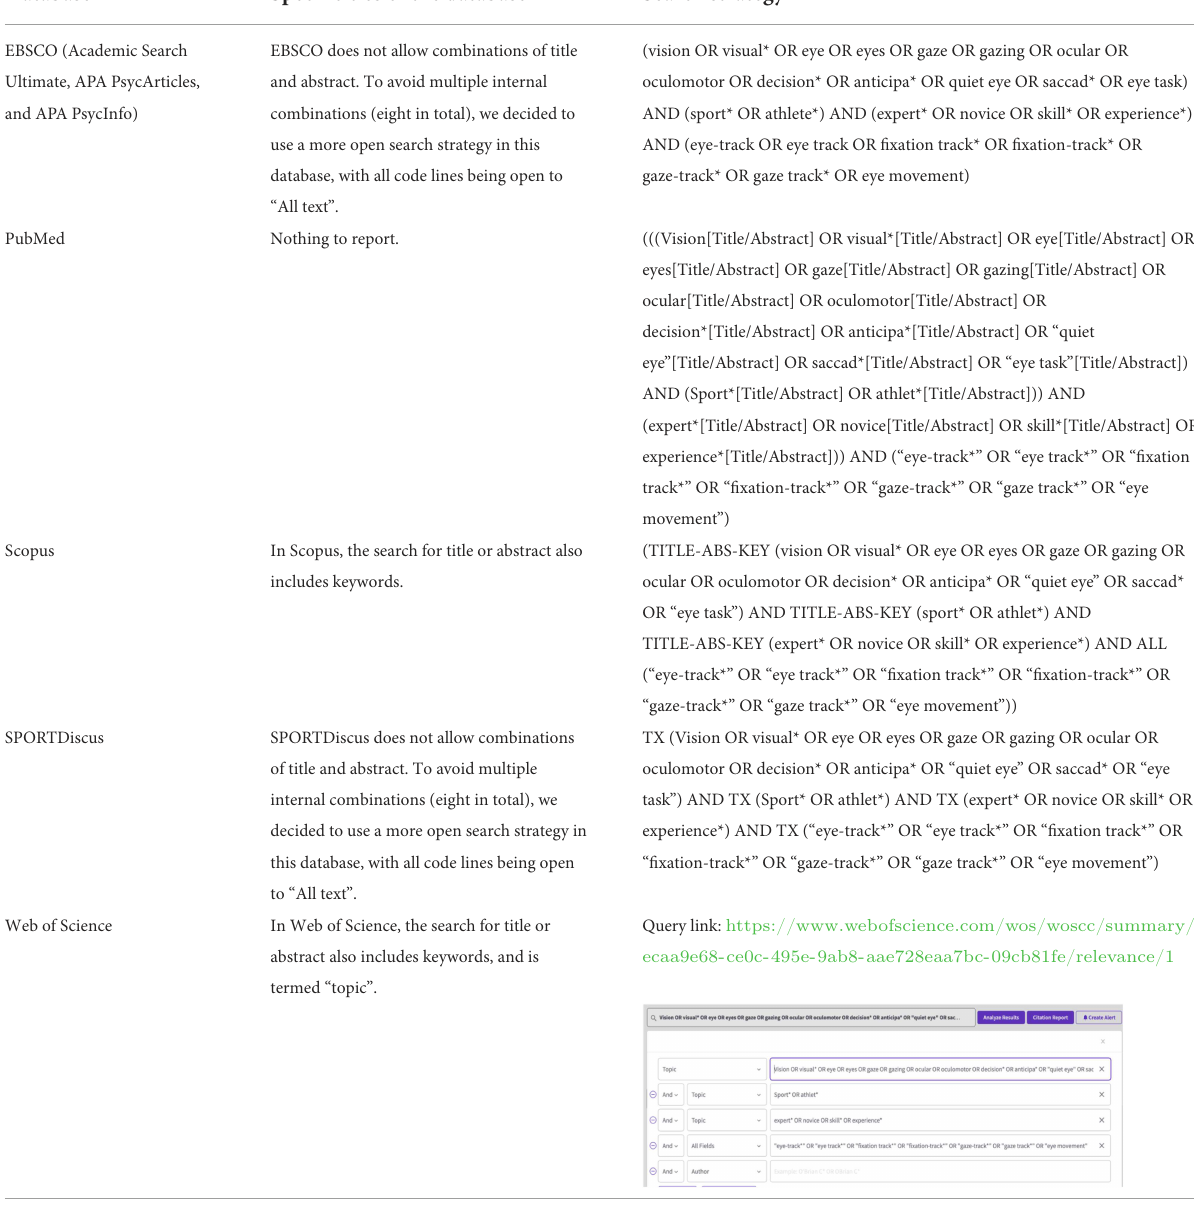
TABLE 1 Full search strategies for each